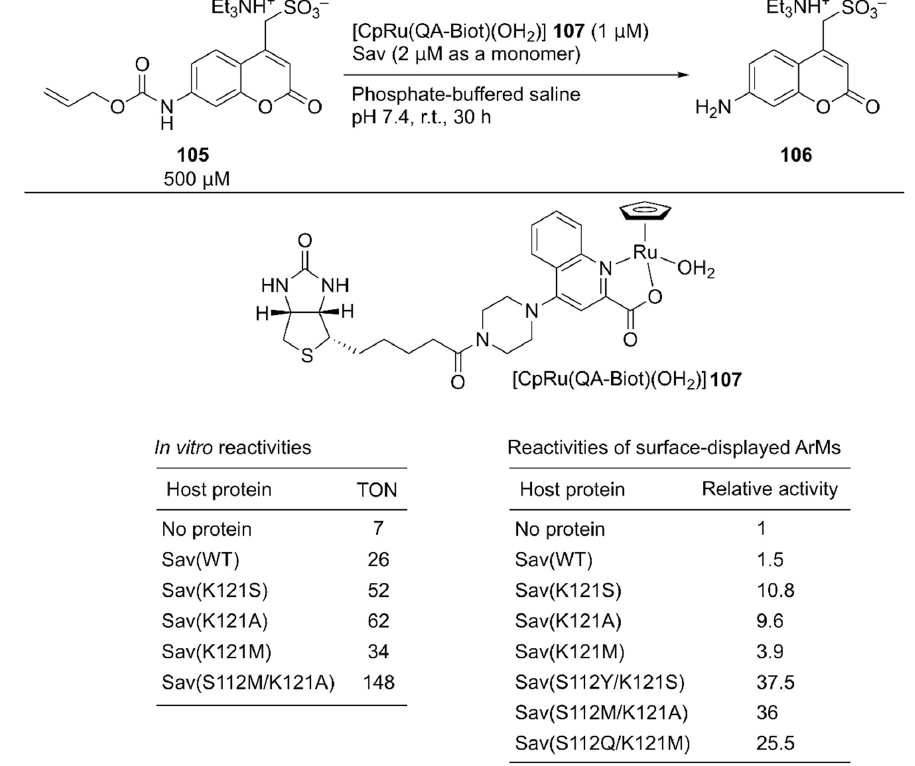
Figure 20. An ArM containing CpRu(2-quinolinecarboxylate) complex 107 was constructed with purified Savs and on the surface-expressed Sav for the allylic dealkylation reaction. Adapted from [120]. See Figure 2 for the crystal structure of Sav.